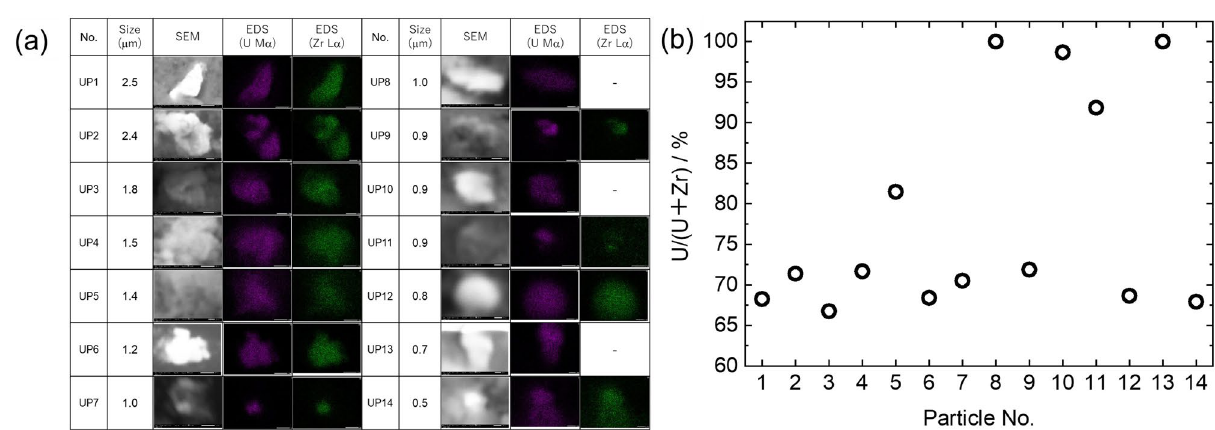
Figure 3. U particles that were obtained from the residue on the polycarbonate filter with a pore size of 5-μm diameter. ( a ) SEM images and elemental maps of the U particles. ( b ) Molar ratios of U/(U + Zr), which were analyzed using